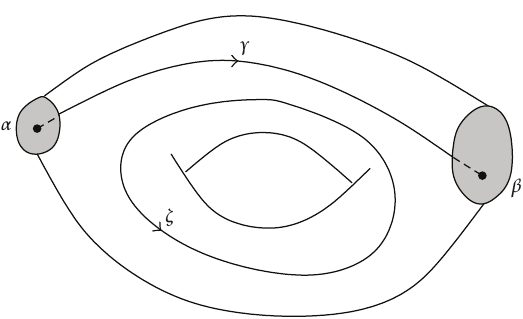
Figure 1: Two representatives of generators of H 1 (cid:6)Ω , Γ(cid:7) . One generator has a nonzero preimage in H 1 (cid:6)Ω(cid:7) , while the other has image in H 0 (cid:6)Γ(cid:7)